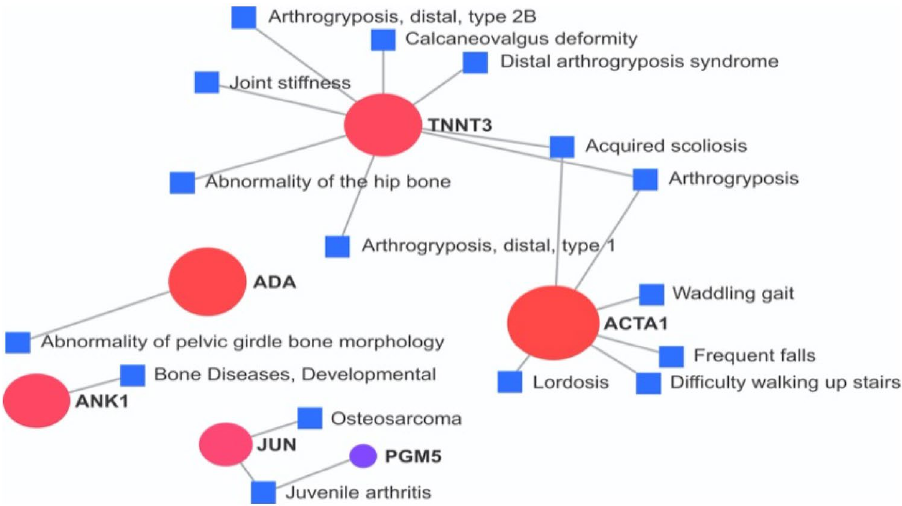
Figure 3. Gene network of differentially expressed genes constructed with the human gene-disease associations database (DisGeNET). In the figure, the genes previously associated with locomotor diseases in humans are shown. Circles represent the DE genes, the squares represent the diseases and connecting lines represent the association between the genes and bone/locomotor diseases, according to the active prediction method of NetworkAnalyst. The size of the circles was related to all conditions associated to the gene, however, for better visualization, we have shown only those related to bone/locomotor